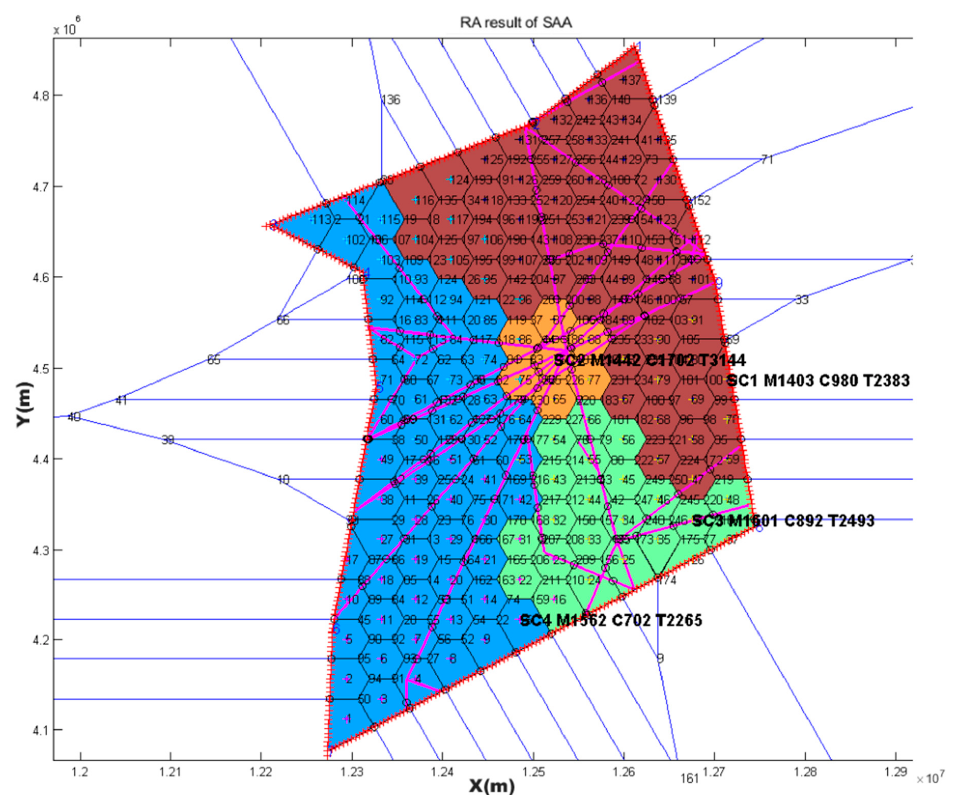
Figure 16. Reconfiguration results based on hexagonal seeds with SAA . Sensors 2019 , 19 , x FOR PEER REVIEW